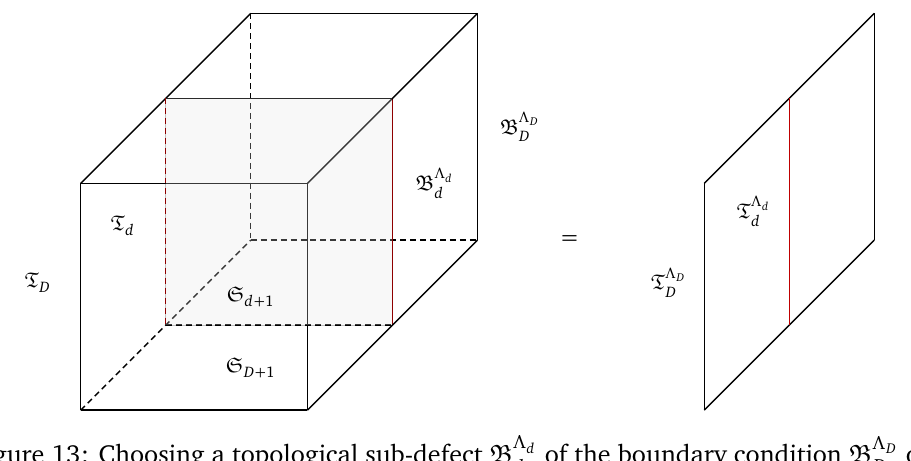
Figure 13: Choosing a topological sub-defect B